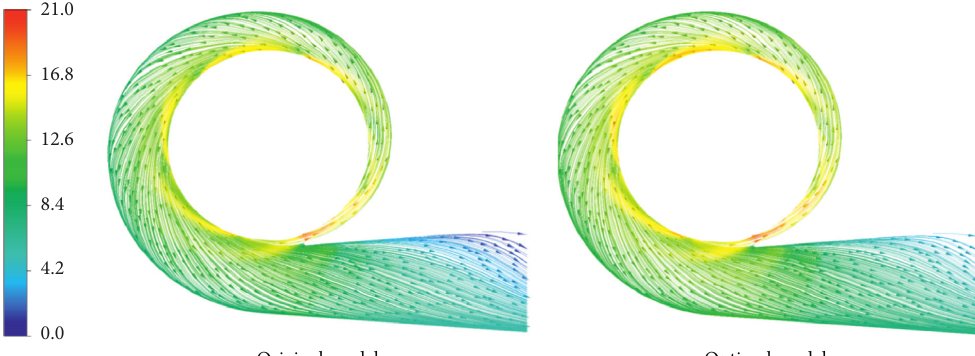
Figure 20: Velocity and streamline distribution at 1.0 Q